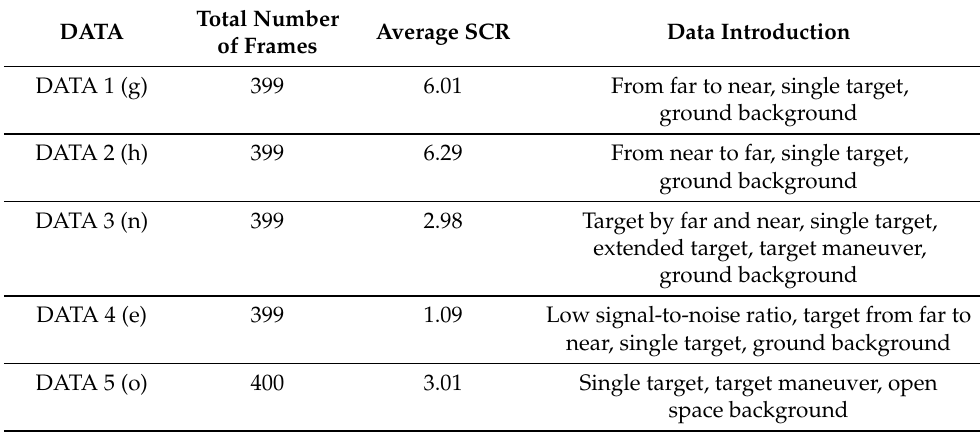
Table 2. An introduction to the representative 5